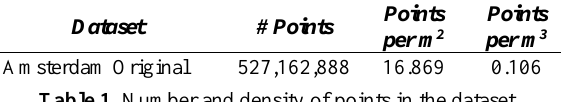
Figure 1. Point cloud of Amsterdam city obtained from AHN3.